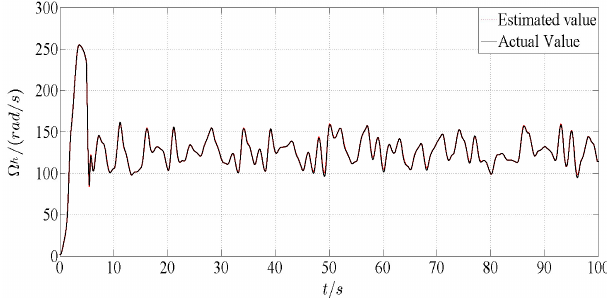
Ω h of high speed